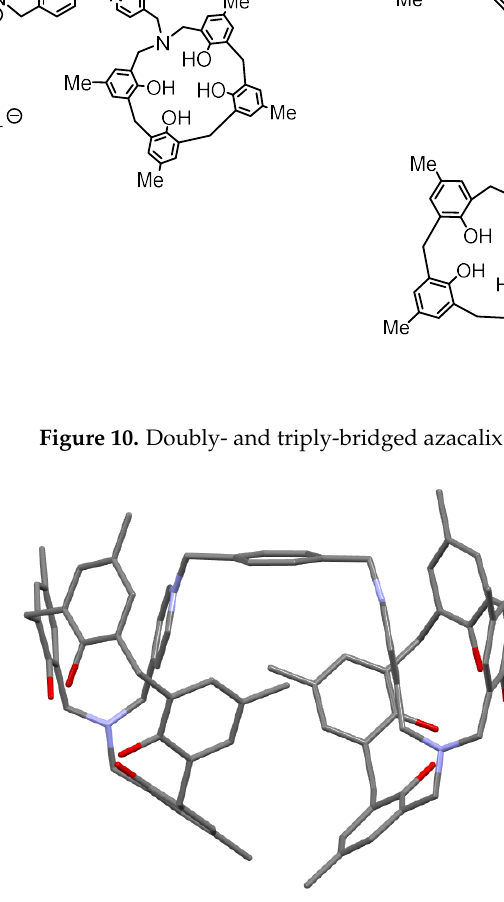
Figure 11. Molecular structure of xylylene-bridged N -(4-picolyl)-azacalix[3.1.1.1]arene 33 . Two Br − are omitted for clarity.